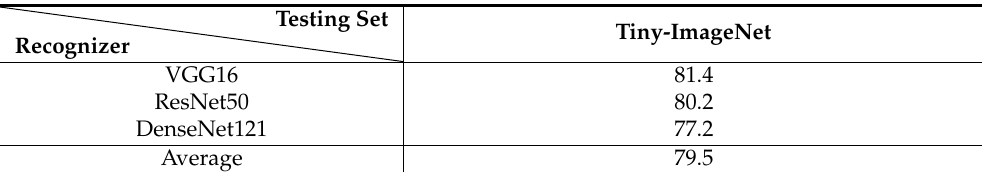
Table 1. Recognition rates of VGG16, ResNet50, and DenseNet121 for original images of Tiny- ImageNet dataset